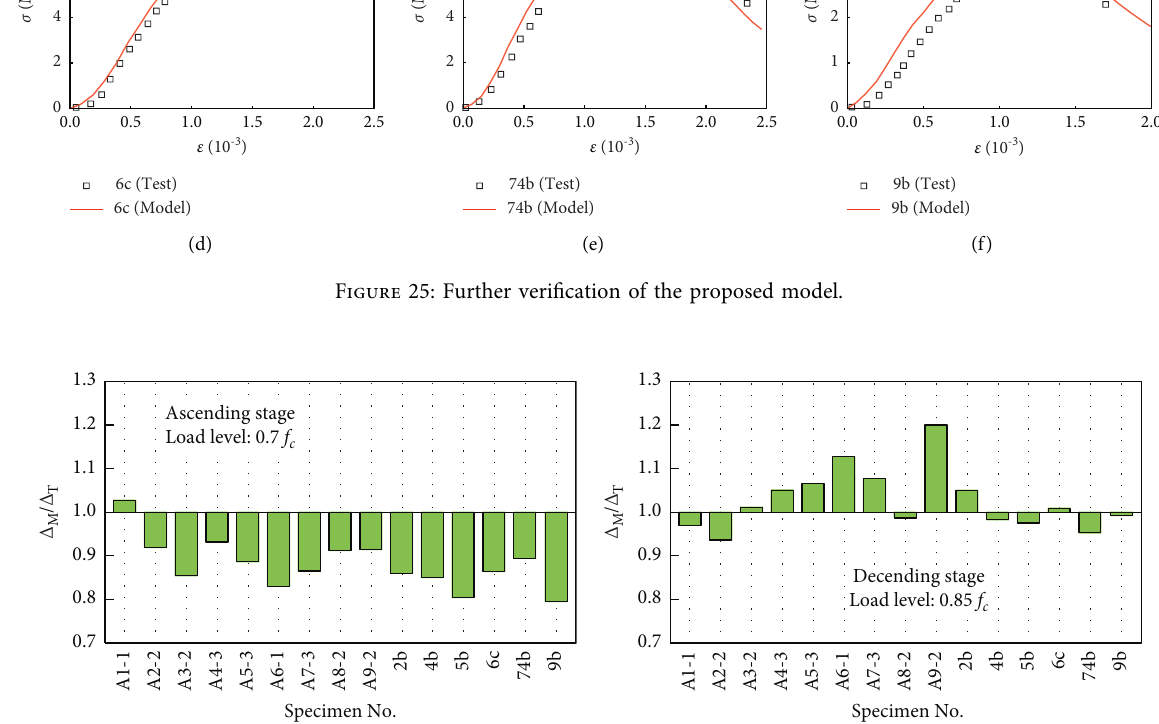
Figure 26: Comparison between the predicted and measured strain